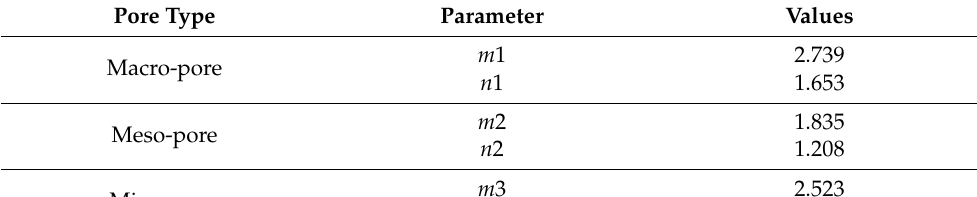
Table 2. Coefficient values of the three components automatically mixed conductivity model.